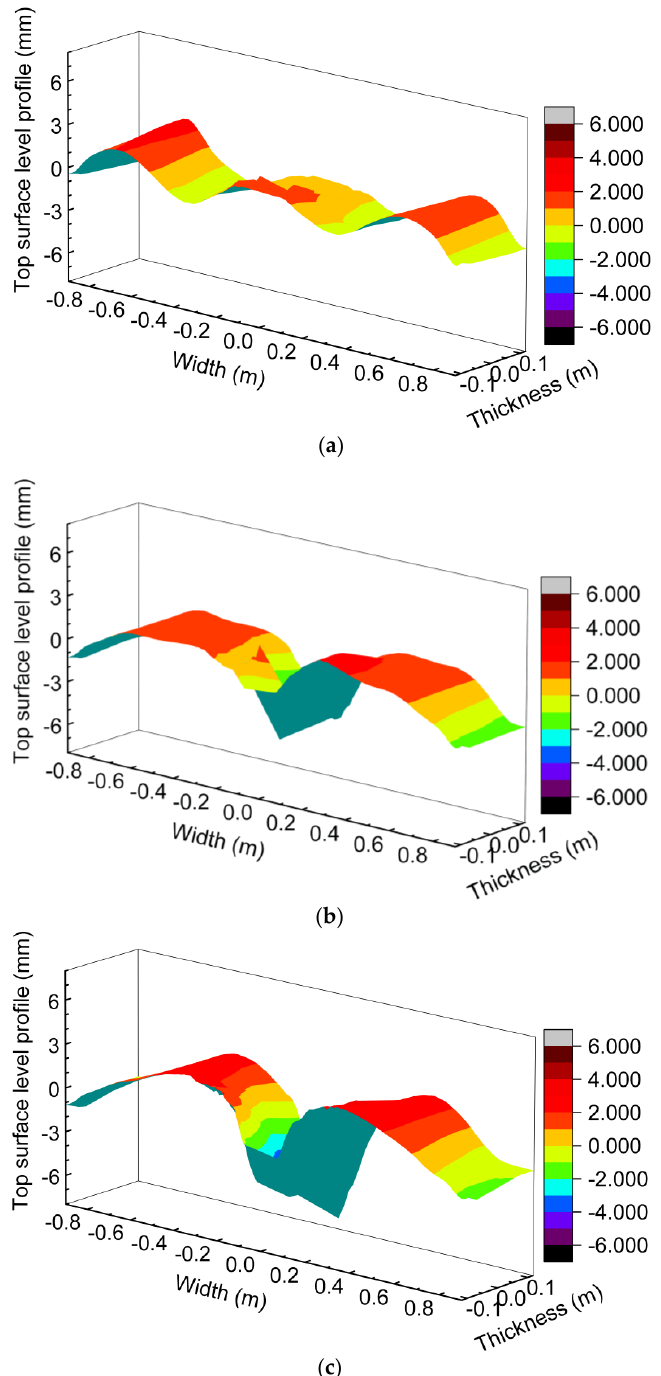
Figure 5. Top surface level profiles of mold at the different argon gas flow rates of ( a ) 6 L/min, ( b ) 10 L/min, ( c ) 14 L/min.